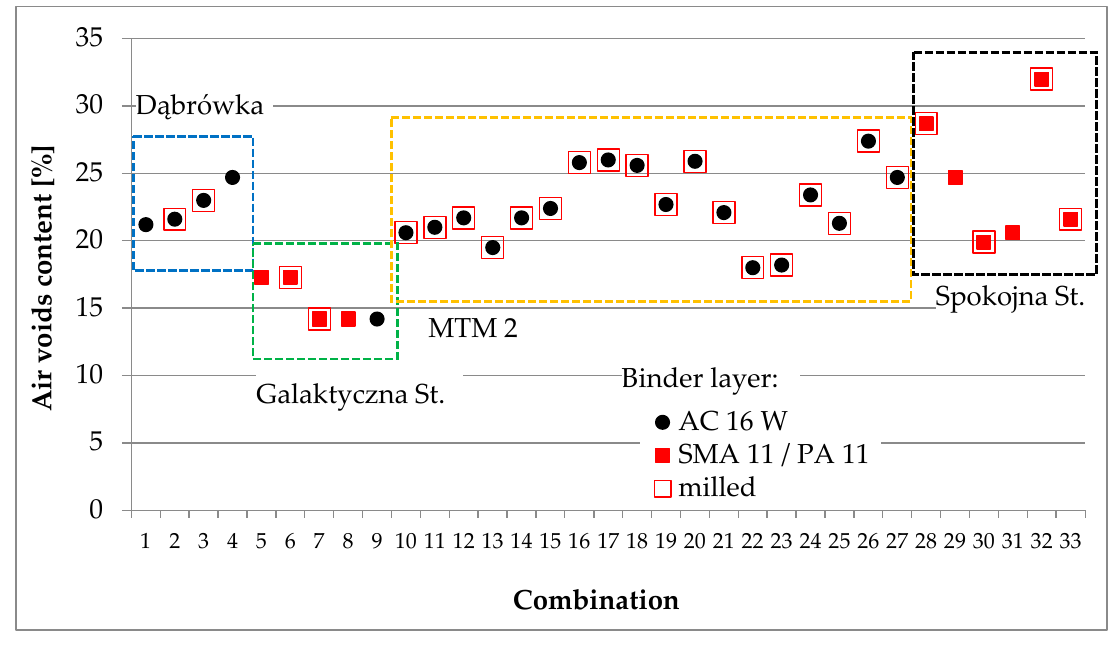
Figure 13. Summary of air voids content results for samples from test sections.